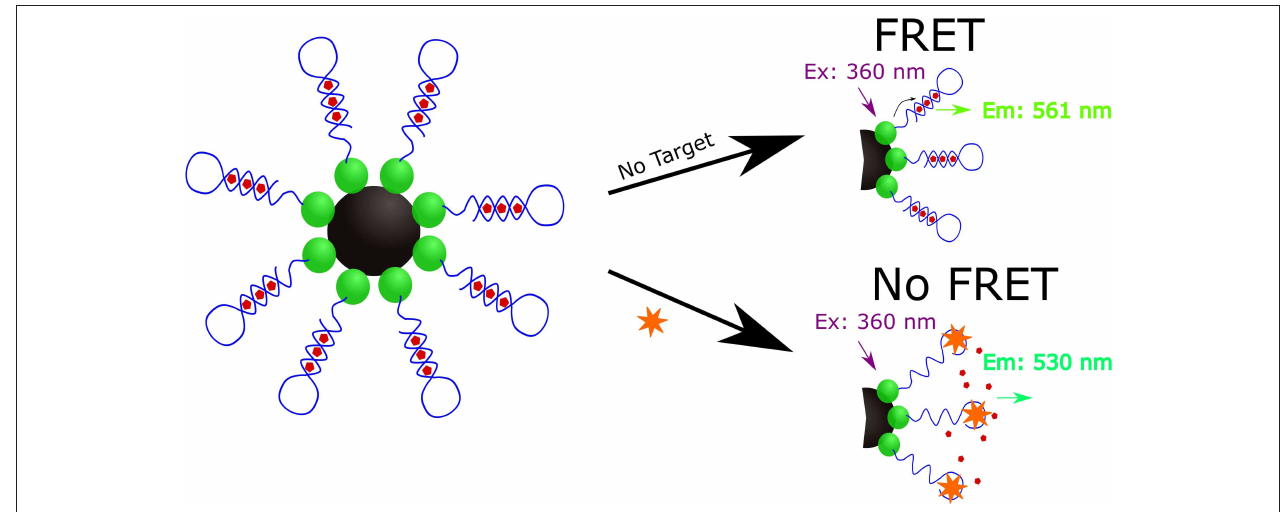
FIGURE 4 | Schematic illustration of the quantum dot mediated FRET based indirect detection of M. aeruginosa based on the direct detection of microcystin-LR (Lee and Son, 2019 ).